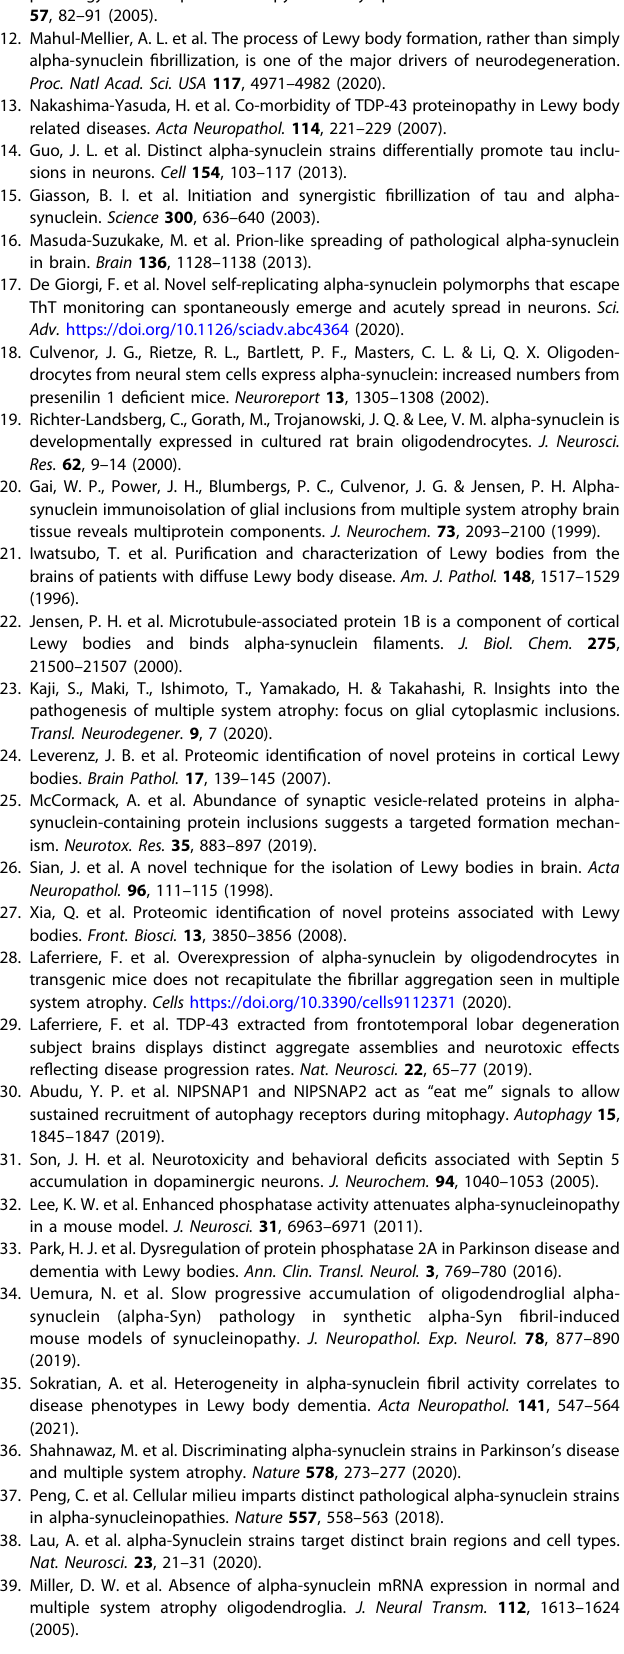
Table 3. Chemicals and kits used in this